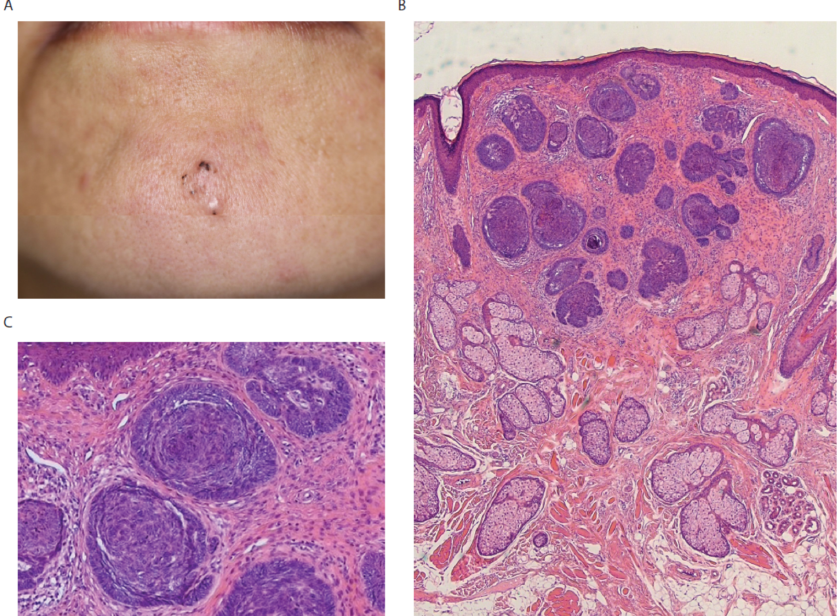
Figure 1. ( A ) A 10 mm skin-colored plaque slightly elevated with several black dots. ( B ) Multiple basaloid cell tumors in the dermis. Proliferation of mature pilosebaceus tissues and ectopic eccrine glands in the dermis. ( C ) Basaloid cell tumors show palisading pattern at the periphery with spaces between the tumor and the surrounding stroma. High magnification of ( B ).